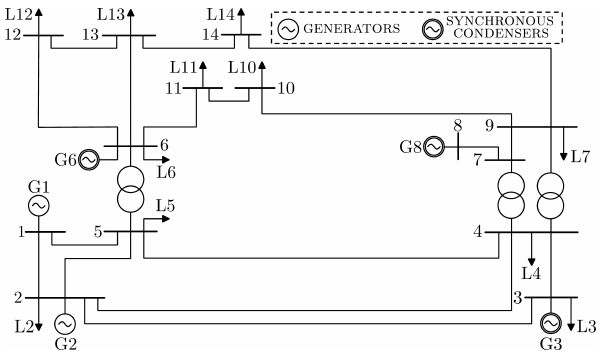
Figure 2. The schematic of the IEEE 14 power